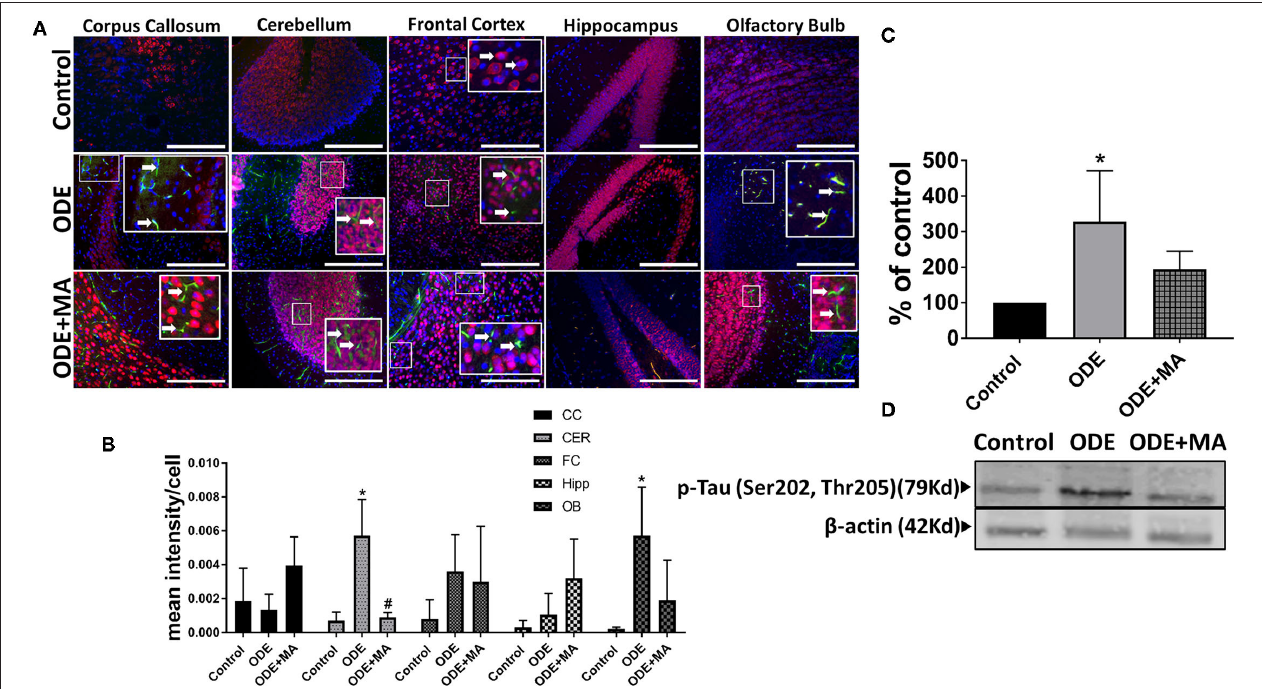
FIGURE 6 | ODE induces hyperphosphorylated Tau (p-Tau) expression in various regions of mice brain. Paraffin-embedded sections from perfused mice brain were stained with anti p-Tau (white arrow, FITC, green) and anti-NeuN (neuronal marker; Cy3, red) antibodies. Also, nuclei were identified with DAPI (blue) (A) . p-Tau expression in IHC was quantified by a blinded investigator. Compared to control, ODE-exposed mice showed higher amounts of p-Tau staining in the cerebellum and olfactory bulb of the brain. MA (C11) treatment significantly reduced p-Tau expression in the cerebellum region of brain (B) . Whole cell lysate from freshly dissected mice brain were processed for western blot analysis. p-Tau and β -actin antibodies (house-keeping protein) detected 79 and 42 kD bands, respectively. Densitometry of normalized bands showed that, compared to controls, ODE exposure increased the p-Tau protein level in mice brain and MA treatment significantly reduced p-Tau protein level (C,D) ( n = 5, *exposure effect, # MA treatment effect, p < 0.05, micrometer bar = 50 µ